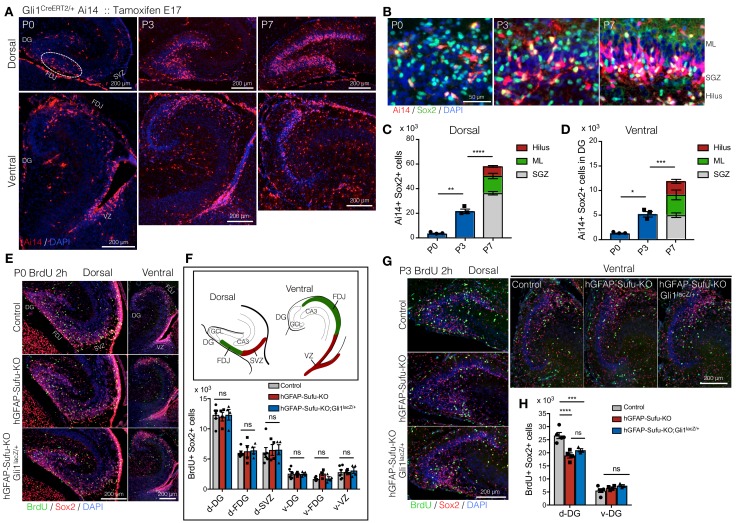
Long-lived NSCs expand in first postnatal week, and loss of Sufu impairs its expansion.(A) Fate tracing of Hh-responding cells at E17.5 in postnatal DG development. Gli1CreERT2/+ Ai14 mice were treated with tamoxifen at E17.5 and Ai14 +Hh responding cells are analyzed in postnatal first week (P0-7). Representative immunofluorescence images for Ai14 (red) and DAPI (blue) in dorsal and ventral hippocampus in sagittal sections. Note that Hh-responding cells labeled by Ai14 at E17.5 sparsely appear in DGs at P0 and subsequently accumulate in SGZ. (B) Representative immunofluorescence images for Ai14 (red), Sox2 (green) and DAPI (blue) in SGZ. (C,D) Quantification of Ai14+/Sox2 +cells in dorsal (C) and ventral (D) DGs [n = 3 biological replicates per group]. The number of long-lived NSCs, indicated as Ai14+/Sox2 +cells, are increased in postnatal first week. (E) BrdU was injected at P0, and pups were sacrificed 2 hr later. Representative immunofluorescence images for BrdU (green), Sox2 (red) and DAPI (blue) in dorsal and ventral DGs of control, hGFAP-Sufu-KO and hGFAP-Sufu-KO;Gli1lacZ/+ mice. (F) Schematic illustration of the dorsal and ventral DG at P0. d: dorsal, v: ventral, FDJ: fimbriodentate junction; SVZ: subventricular zone. The bar graph indicates the number of Sox2+/BrdU +cells in each region [Control, n = 6; hGFAP-Sufu-KO, n = 4; hGFAP-Sufu-KO;Gli1lacZ/+, n = 4]. (G) BrdU was injected at P3, and pups were sacrificed 2 hr later. Representative immunofluorescence images for BrdU (green), Sox2 (red) and DAPI (blue) in dorsal and ventral DGs of control, hGFAP-Sufu-KO and hGFAP-Sufu-KO;Gli1lacZ/+ mice. (H) Quantification of Sox2+/BrdU +cells in dorsal and ventral DGs [Control, n = 5; hGFAP-Sufu-KO, n = 4; hGFAP-Sufu-KO;Gli1lacZ/+, n = 3]. Values represent mean ±SEM; ns: p>0.05, *p<0.05, **p<0.01, ***p<0.001, ****p<0.0001. ANOVA with Tukey post-hoc tests.10.7554/eLife.42918.020Figure 5—source data 1.Extended numerical data and statistical analysis for Figure 5.